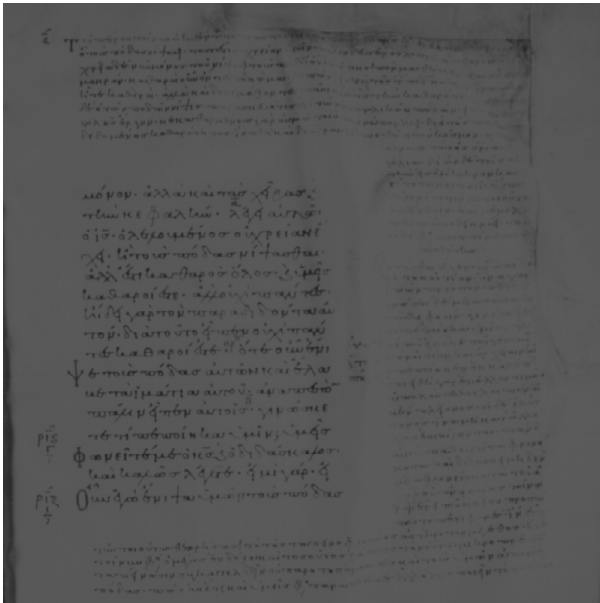
Figure 5. GA 2604 (CBL W 139) 347r in the NTVMR © The Trustees of the Chester Beatty Library, Dublin